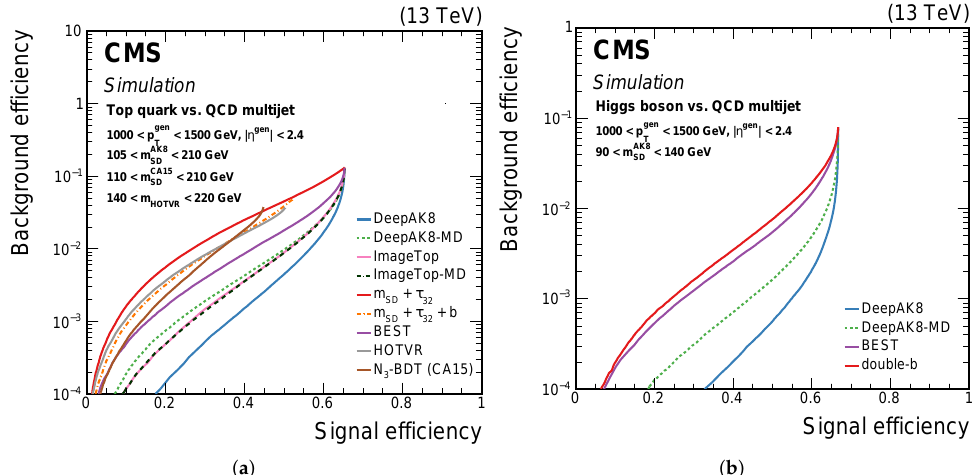
Figure 6. Performance comparison in terms of ROC curves on ( a ) top quark and ( b ) the Higgs boson taggers